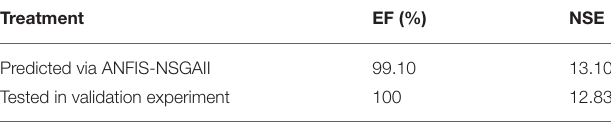
TABLE 4 | Validation of the predicted vs. tested data for embryogenesis frequency (EF) and number of somatic embryo (NSE) of chrysanthemum. Treatment EF (%) NSE Predicted via ANFIS-NSGAII 99.10 13.10 Tested in validation experiment